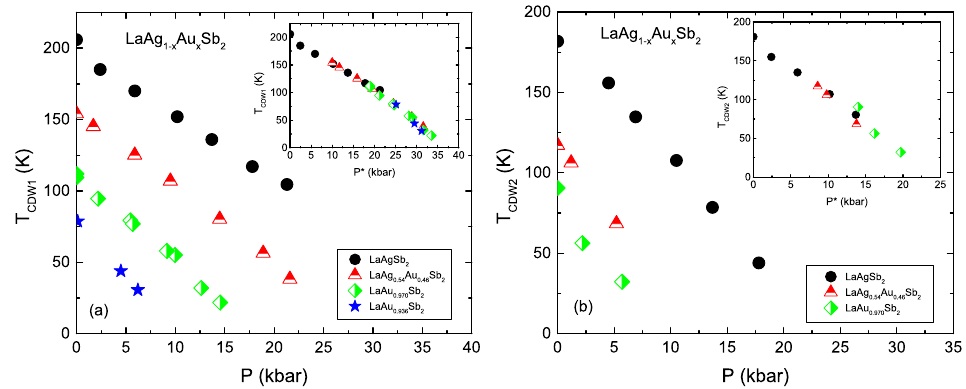
Figure 10. Pressure dependence of ( a ) T CDW 1 and ( b ) T CDW 2 for different LaAg 1 − x Au x Sb 2 shown on the same plot. Data for LaAu x Sb 2 are taken from Ref. [17]. Insets: the same data positioned on universal lines by horizontal shifts, ∆ P